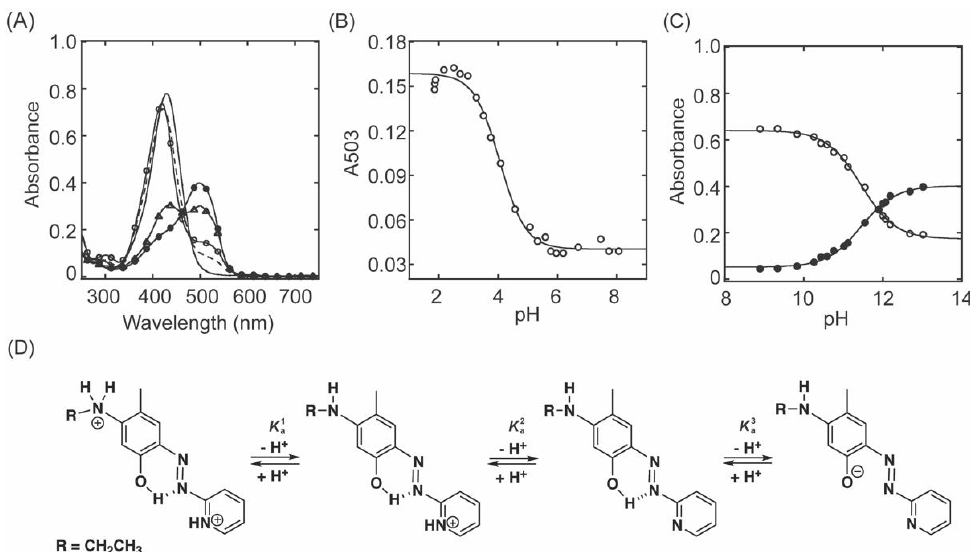
Figure 3. UV − vis spectroscopic titration of p K a s of 1 . ( A ) UV − vis spectra of 1 at pH 1.86 Figure 3. UV-vis spectroscopic titration of p K a s of 1 . ( A ) UV-vis spectra of 1 at pH